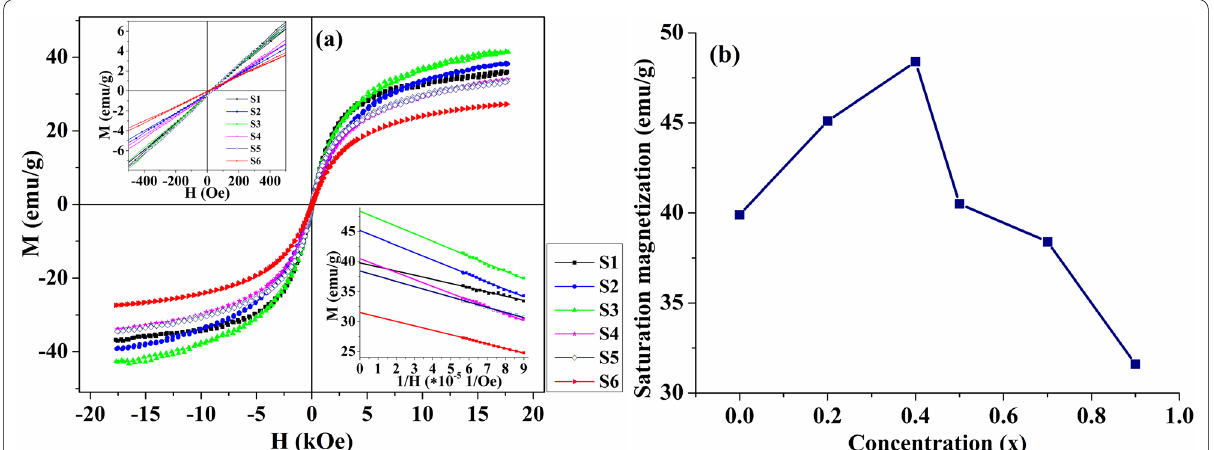
x 0.9 a) and concentration dependence of the saturation magnetization (b). The upper ≤ ≤